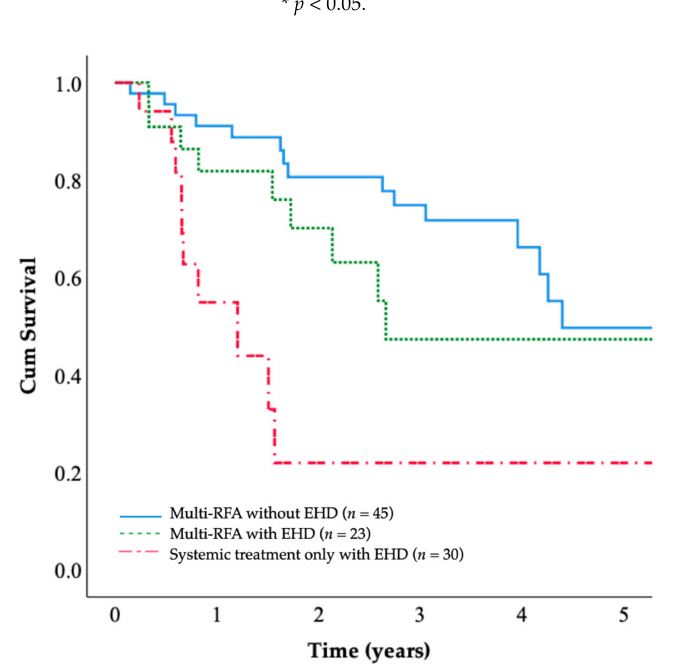
Figure 4. The OS rates of patients with or without extrahepatic metastasis were not significantly different ( p = 0.134) and were superior to that of the systemic treatment only group ( p <